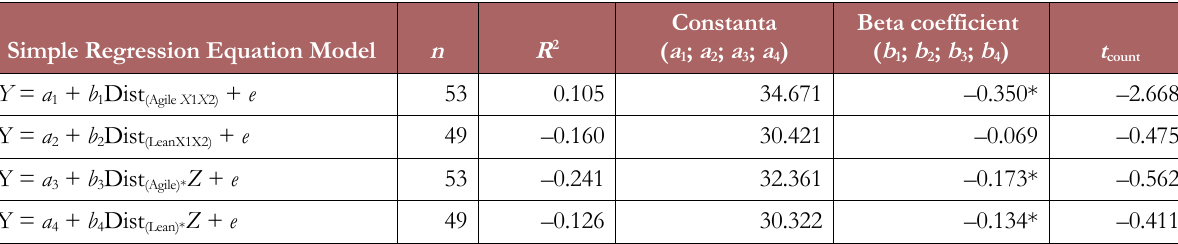
Table 5. The Summary of Regression